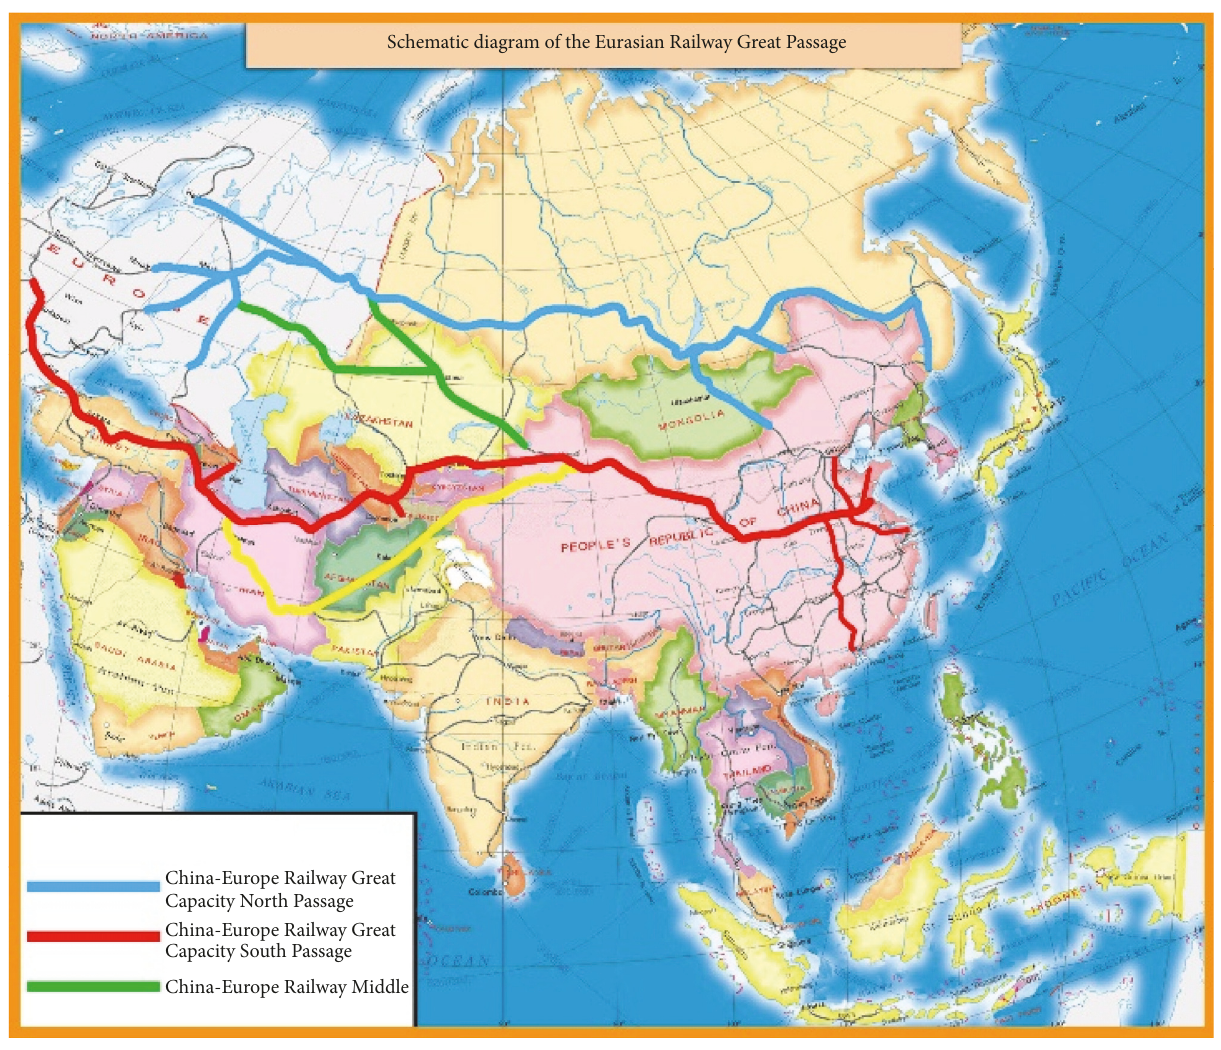
Figure 1: “The Belt and Road” railway